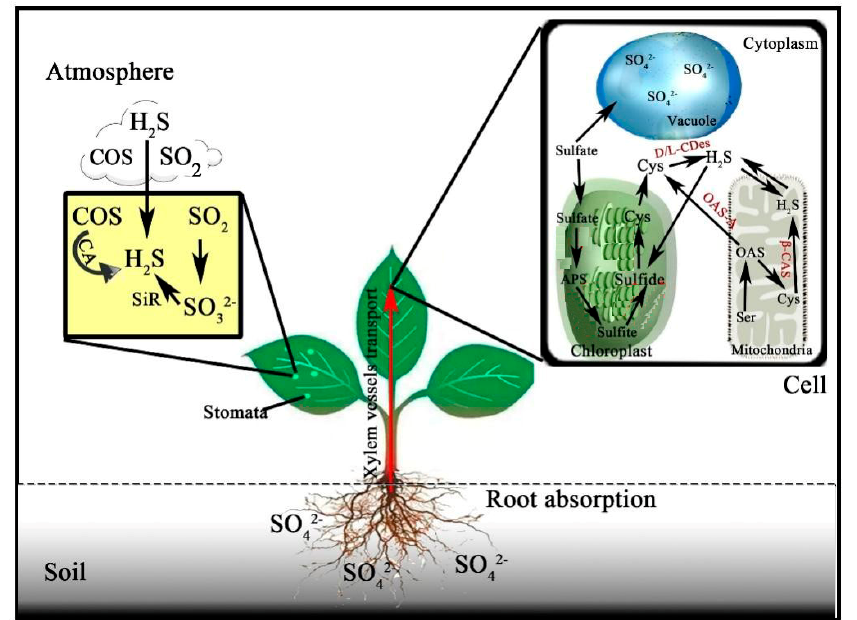
Figure 2. H 2 S plays a pivotal role in sulfur metabolism in plants . Sulfur elements needed for